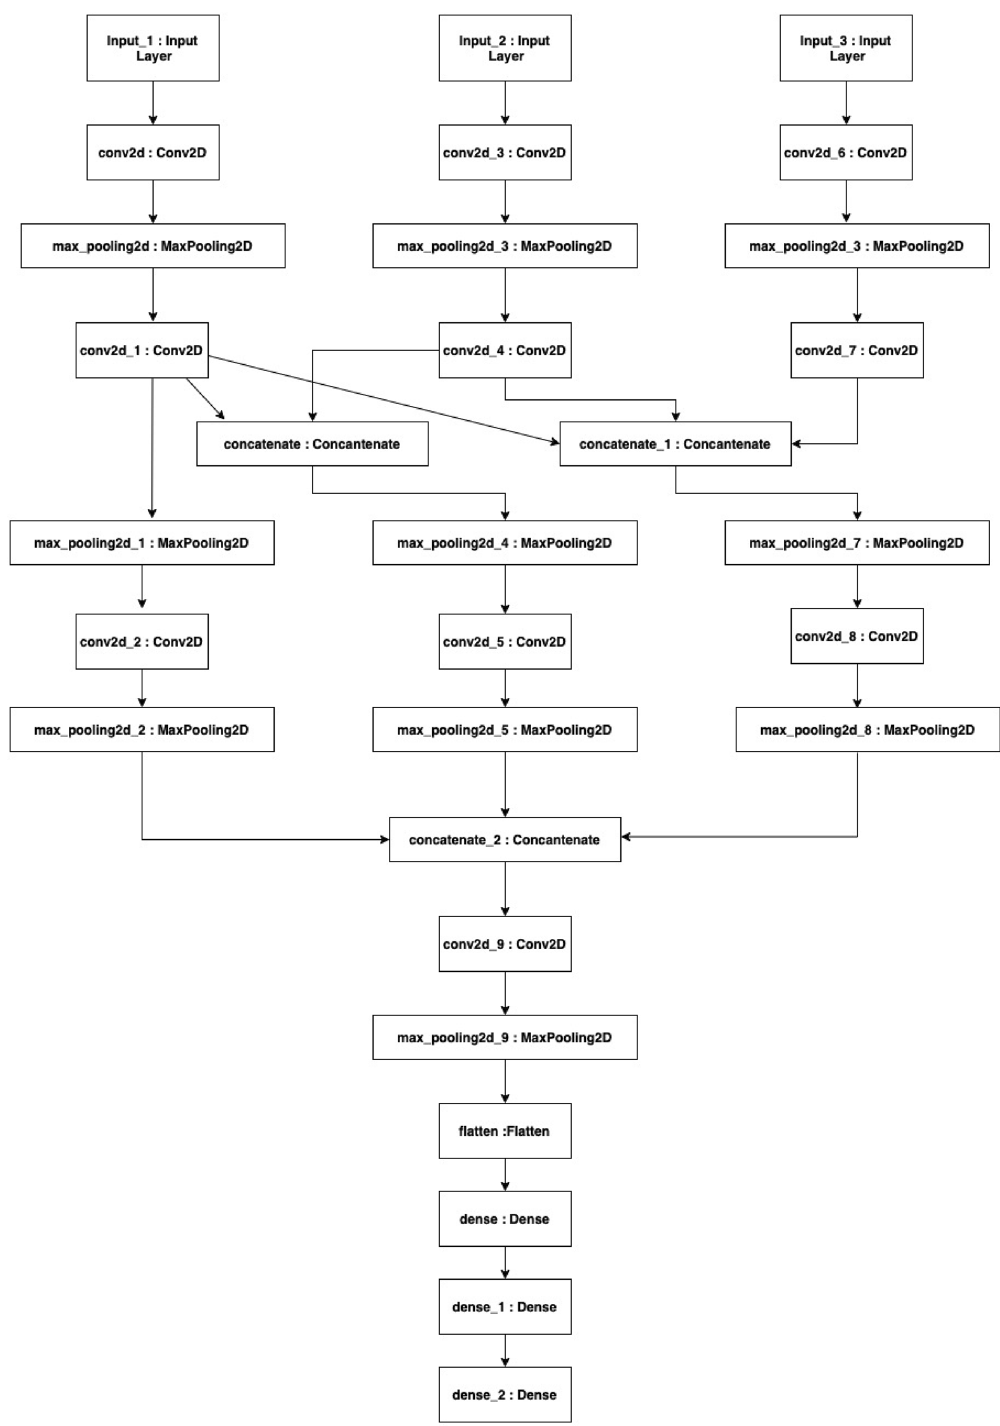
Figure 3. Image channel-based overlapping CNN tower